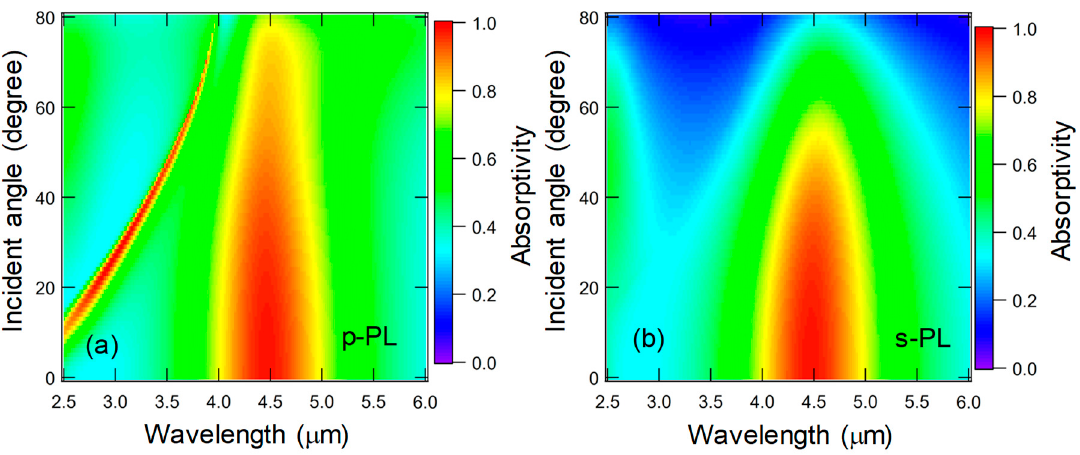
Figure A7. Simulated spectral absorptivity/emissivity maps to the incident angle to an MDM metasurface composed of HfN and SiO 2 with P = 2.0 µm, d = 1.2 µm, T g = 130 nm, and T d = 200 nm: ( a ) p-polarization and ( b ) s-polarization.